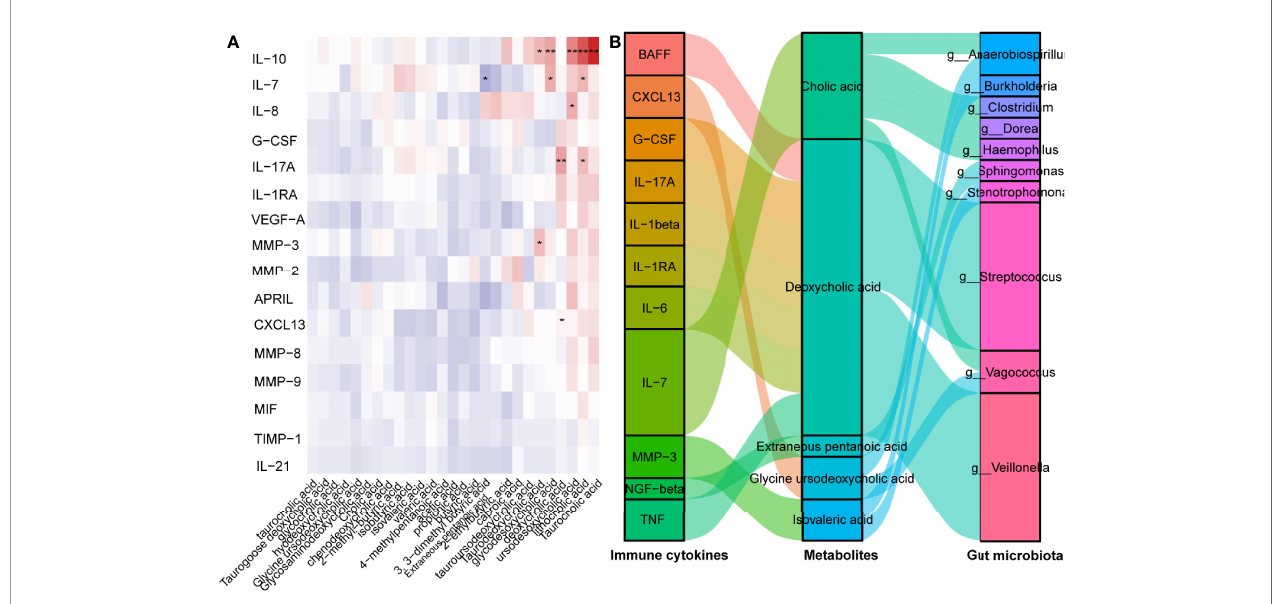
FIGURE 5 | GUDCA increased circulating Tfh cell and CXCL13 levels in mice. (A) Correlation between in fl ammatory factors and metabolites were analysed by Spearman ’ s correlation. Signi fi cant changes are denoted as follows: **p < 0.01 and *p < 0.05 . (B) Spearman ’ s correlation of serum in fl ammatory cytokines with gut metabolites, gut metabolites and gut bacterial